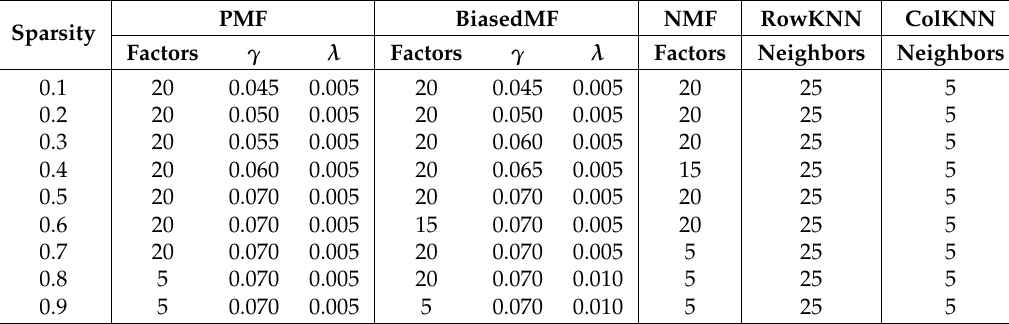
Table 2. Most adequate hyper-parameters reported by a grid search optimization on the [40] dataset. PMF BiasedMF NMF RowKNN ColKNN Sparsity